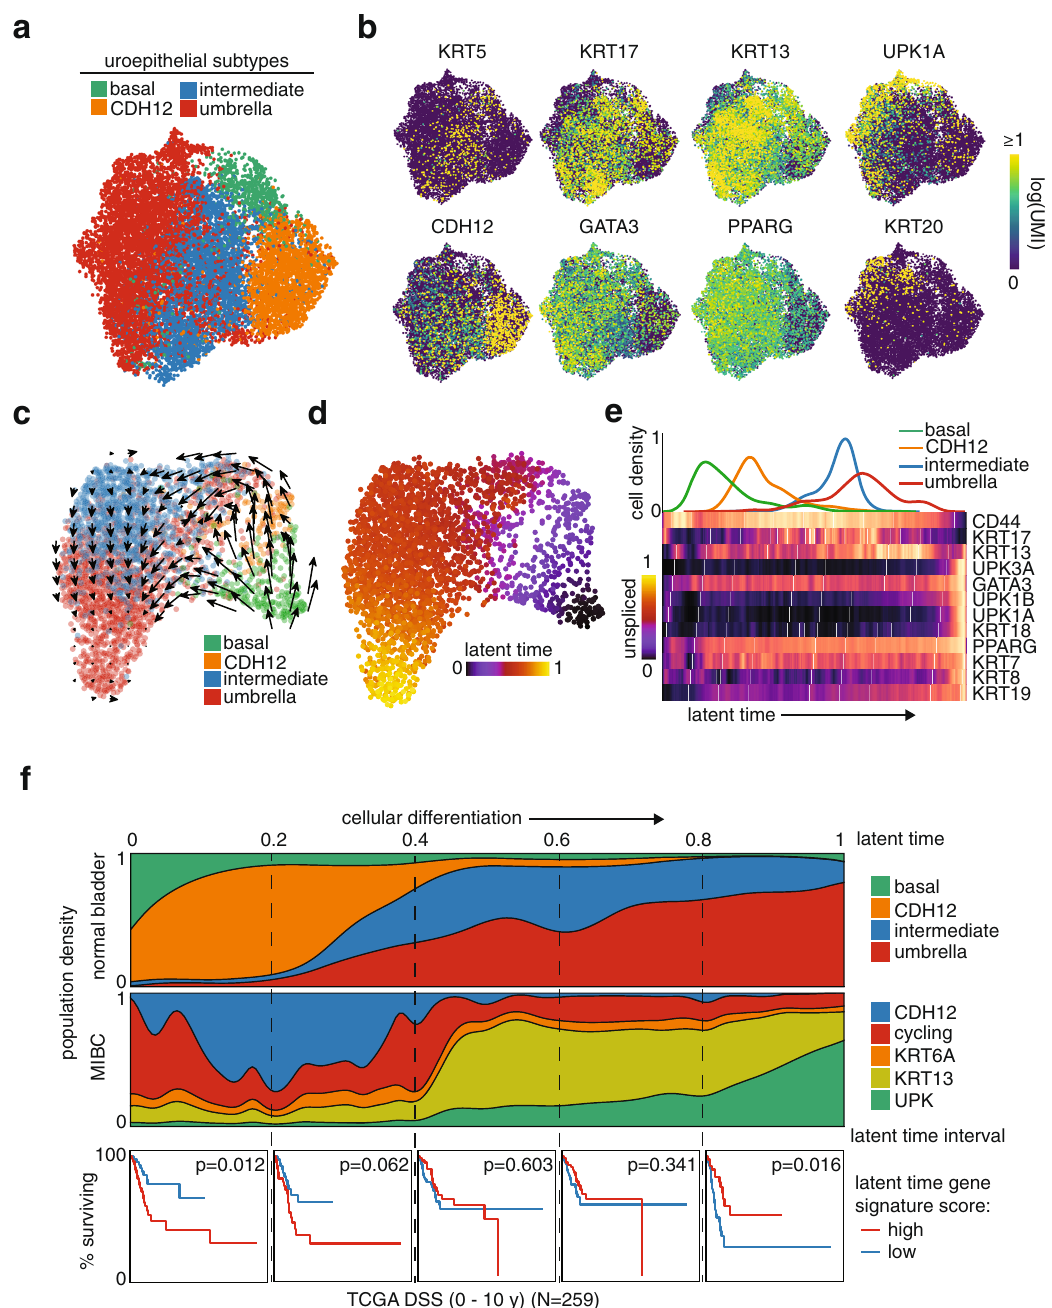
Fig. 2 CDH12 + tumor population resembles characteristics of early undifferentiated urothelial cells and correlates with poor clinical outcome. a UMAP of 12,819 uroepithelial nuclei obtained from histologically normal bladder and colored by unsupervised clustering. b Uroepithelial differentiation-related marker gene expression. c RNA velocity latent time trajectory in healthy bladder epithelial nuclei from a representative patient. d RNA velocity-based latent time of the nuclei shown in c . e Epithelial population density (top) and heatmap of uroepithelial marker gene expression (bottom) in nuclei from d ordered by increasing latent time. f Epithelial population distribution across latent time for all normal samples combined (top row) or MIBC samples based on normal nearest neighbor analysis (middle row). Normal samples were combined by collating the latent times from velocity analyses performed on each of the 4 samples independently. Disease-speci fi c survival of high-grade MIBC in TCGA strati fi ed by gene signature scores derived from MIBC nuclei in the latent time intervals demarcated by the dashed lines (bottom row, log-rank test between top and bottom quartiles N = trajectory 22,23 . This identi fi ed a trajectory that initiated in basal cells and subsequently diverged into two differentiation paths: one traveling through the CDH12 population and one that skips the CDH12 population (Fig. 2c, d, representative sample shown).